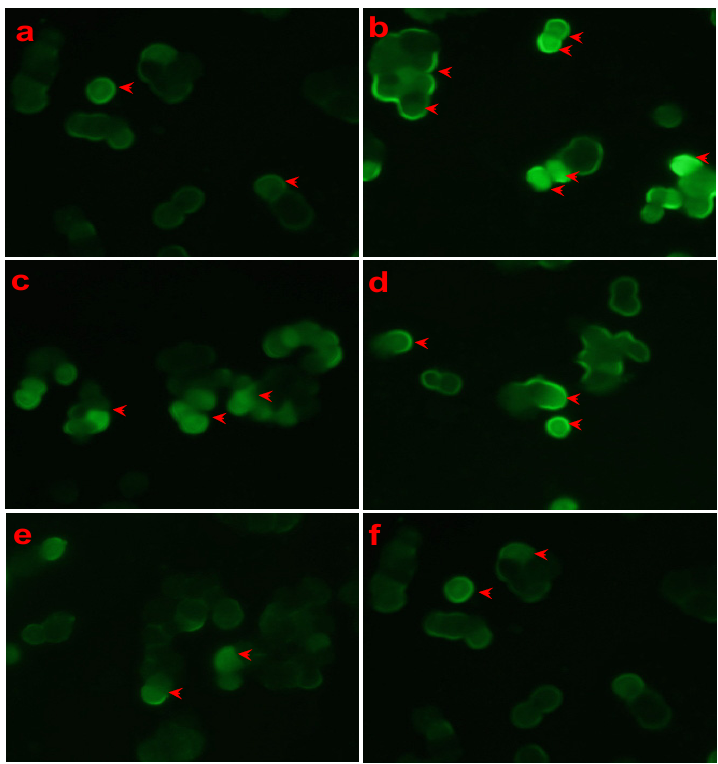
Figure 4. Effect of LSS on mitochondria membrane potential in PC12 cells treated with or without A β 25 ‐ 35 (20 μ mol/L) with rhodamine 123 ‐ staining (400×). ( a ) Cells were treated with medium for 13 h without A β 25 ‐ 35 ; ( b ) cells were treated with medium for 1 h and followed by A β 25 ‐ 35 for 12 h; ( c ) cells were treated with LSS 0.95 mg/L for 1 h and followed by A β 25 ‐ 35 for 12 h; ( d ) cells were treated with LSS 1.90 mg/L for 1 h and followed by A β 25 ‐ 35 for 12 h; ( e ) cells were treated with LSS 3.80 mg/L for